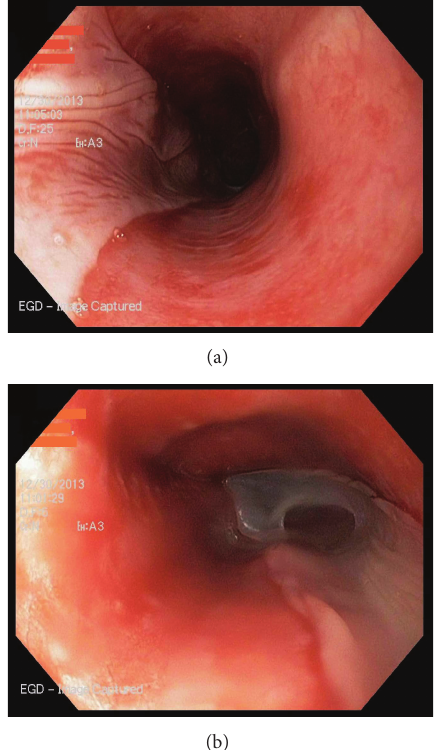
Figure 3: EGD showing vertical fissuresin thedistal esophagus with sloughing of the